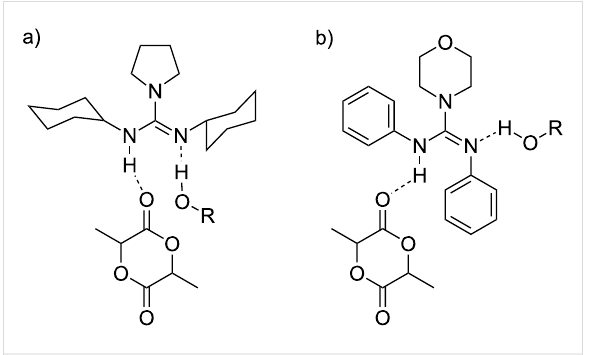
Figure 3: Supposed intermediates resulting from either a cyclohexane- substituted guanidine (a) [18] or an aromatic substituted guanidine (b) with an alcohol and